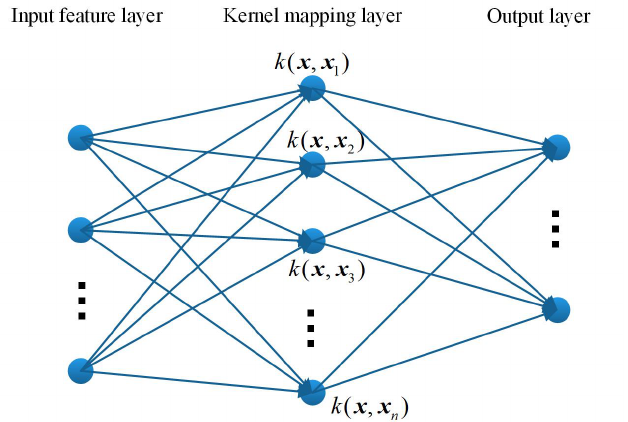
Figure 1. Network structure of the original Kernel Extreme Learning Machines (KELM)